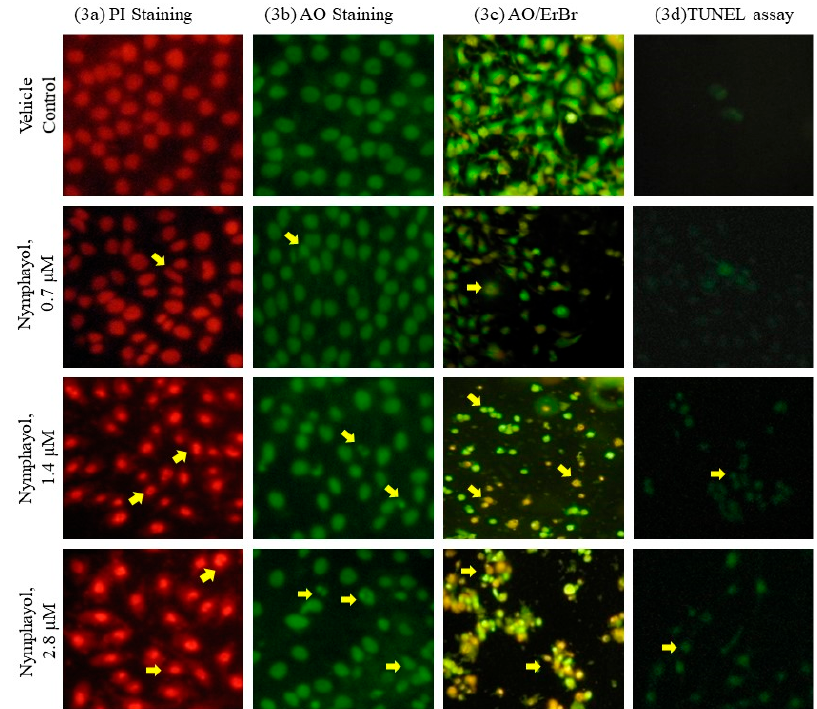
Figure 3. Propidium iodide (PI) ( a ), acridine orange (AO) staining ( b ), acridine orange / ethidium bromide (AO / ErBr)-staining ( c ) and terminal deoxynucleotidyl transferase dUTP nick end labeling (TUNEL) assay ( d ) images of vehicle control dimethyl sulfoxide (DMSO), 0.7 µ M, 1.4 µ M, and 2.8 µ M of nymphayol treated MCF-7 cells after 48 h shown at 200x. In PI staining; 1.4 µ M and 2.8 µ M doses of nymphayol with a horse shoe shaped nucleus and shrunken nucleus confirmed the nuclear pyknosis and apoptosis. In AO / ErBr staining; 2.8 µ M dose of nymphayol clearly showed proapoptotic (bright green), early apoptotic (light green) and late apoptotic (orange) cells.